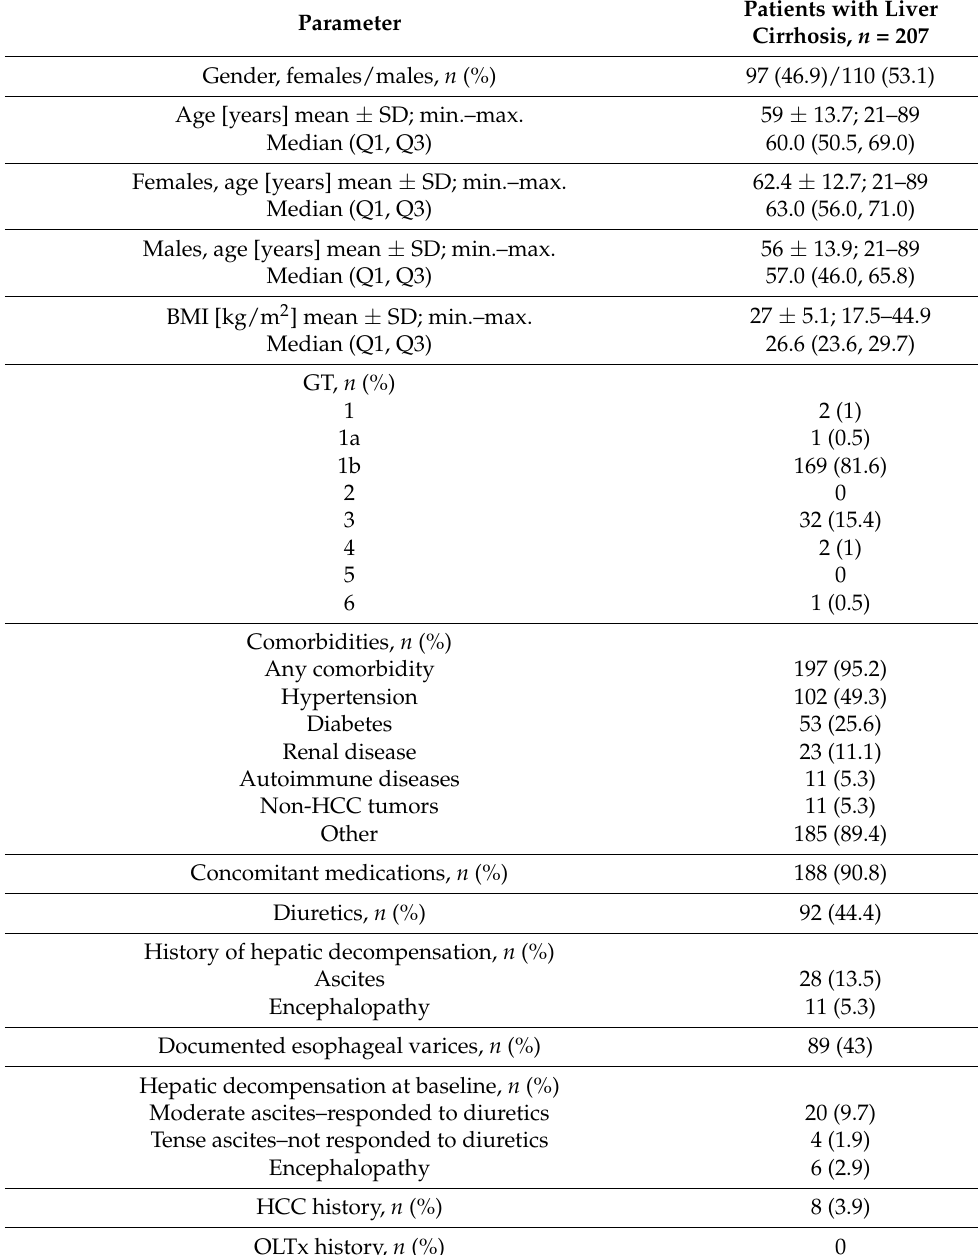
Table 2. Characteristics of 207 Cirrhotic Patients Infected with HCV Included in the Analysis. Parameter